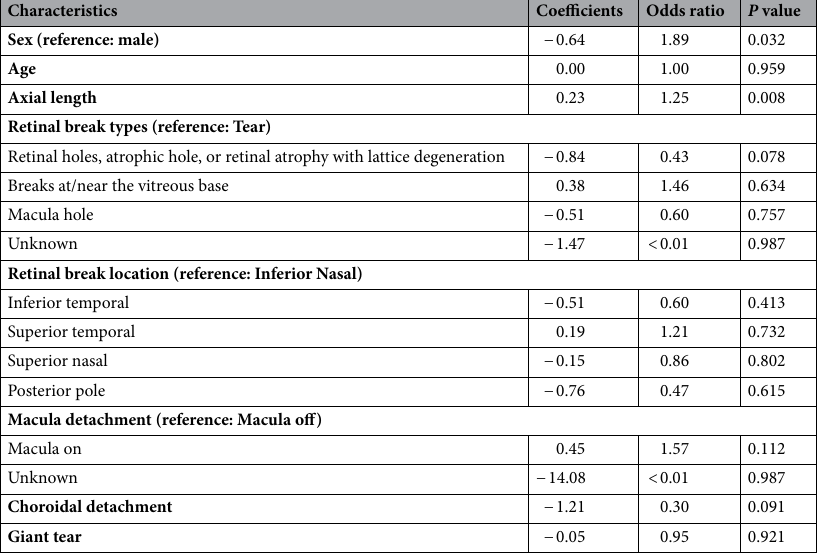
Table 5. Factors focusing on sex differences associated with the days from onset to surgery in Kyushu region analyzed by multiple logistic regression.